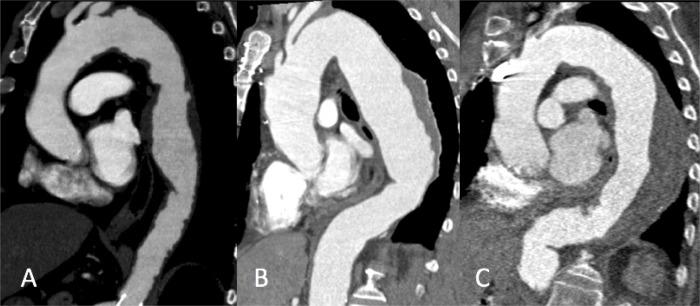
Three groups of amount of tortuosity.A: low tortuosity < 30°; B: moderate tortuosity 30° - 60°; C: high tortuosity > 60°.